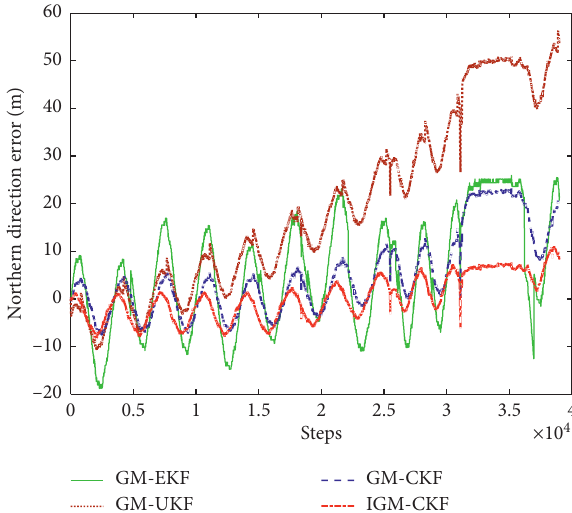
Figure 8: Comparison of the errors in the northern direction using 39,000 data